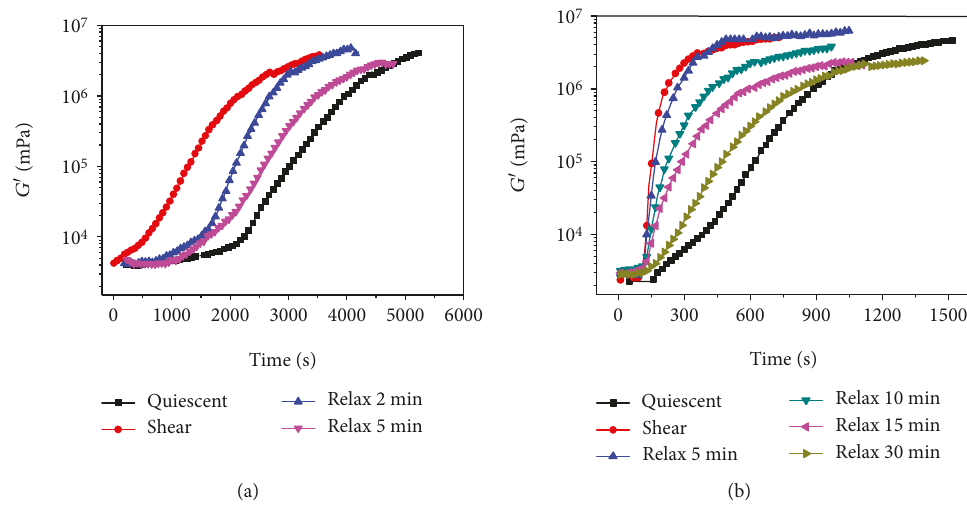
Figure 2: Evolution of the storage modulus G ′ during isothermal crystallization at 135 ° C in (a) iPP and (b) β -nucleated iPP under quiescent, sheared, and partially relaxed conditions ( shear rate = 40 s − 1 , shear time = 10 s , T S = 170 ° C , and T R = 170 ° C ).